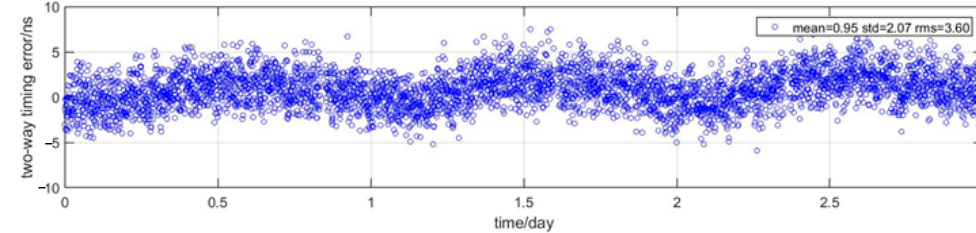
Figure 10. RDSS two-way timing accuracy (orbit maneuver state).